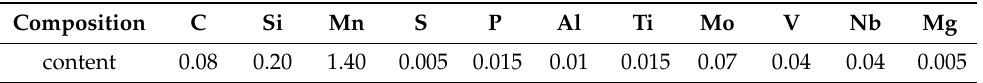
Table 1. The chemical composition of the steel trial